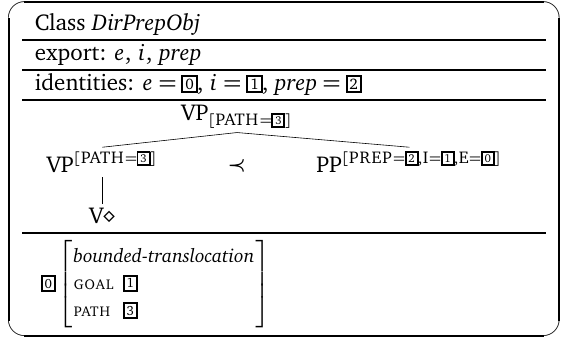
Figure 28: MG class for a directional PP